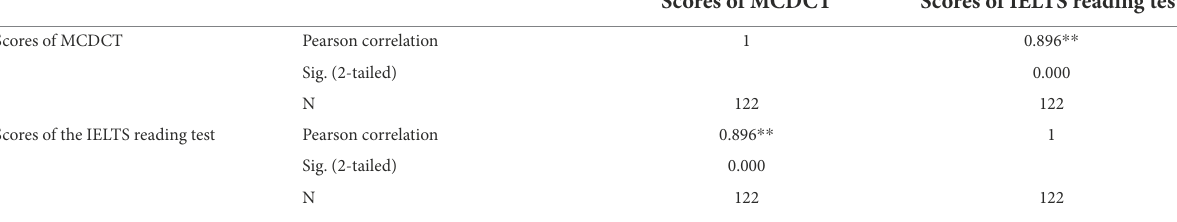
TABLE 5 The correlation between participants’ MCDCT and IELTS reading test